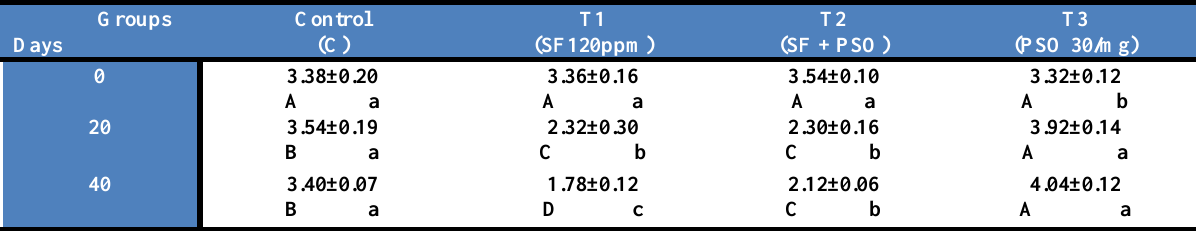
Table, 2: Effect of pomegranate seed oil (PSO) on serum albumin concentration (mg/dl) in female rats treated with sodium fluoride (SF).